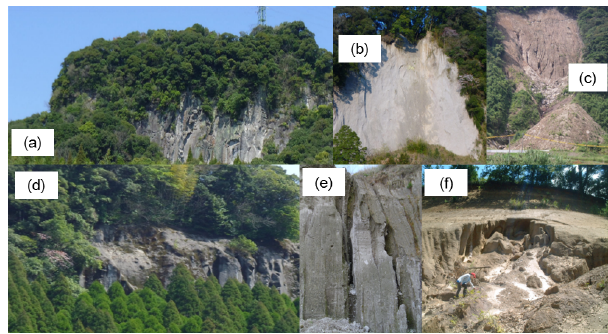
Figure 3. Characteristics of geomorphic features in Shirasu areas: (a) isolated buttes and mesas with active mass wasting along mar- gins; (b) slab-type failures on steep slopes; (c) slightly deeper planar failures on less steep slopes; (d) shallow landslides along inner val- ley gorges; (e) shallow piping phenomena; and (f) soil piping and subsequent gully formation.